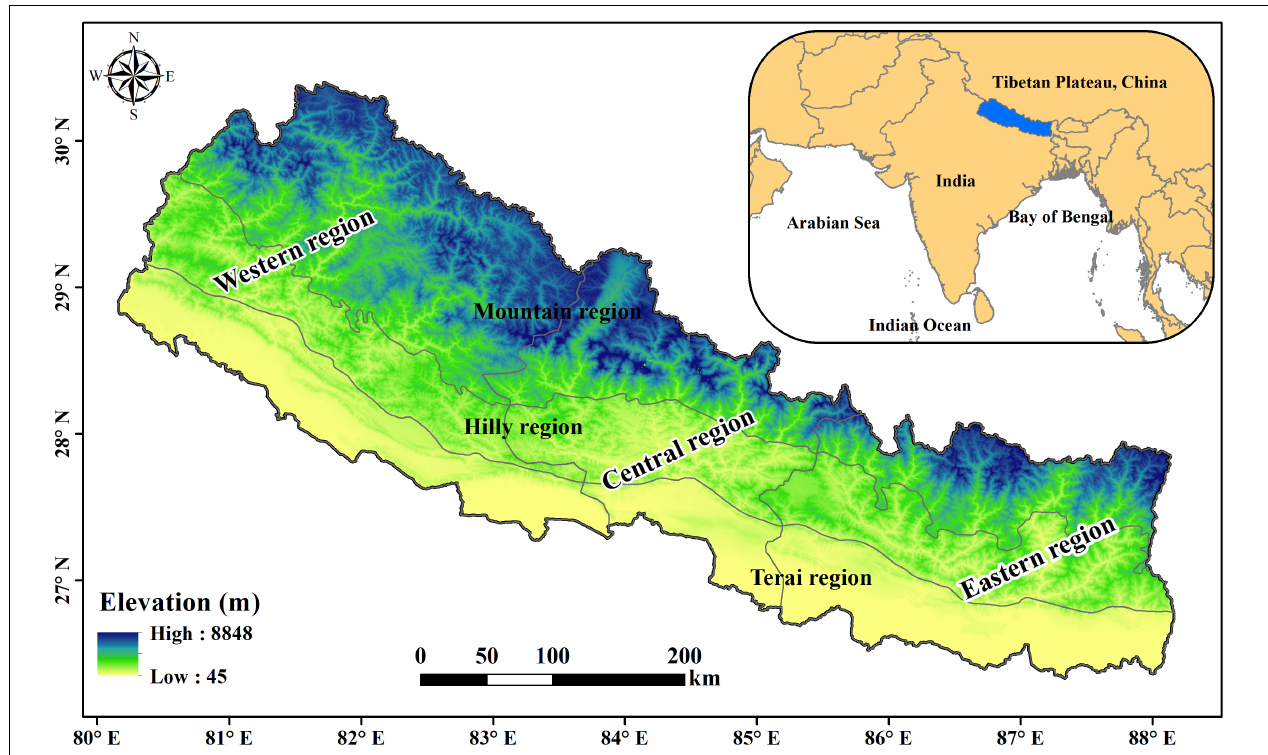
FIGURE 1 | The study area, Nepal with different regions. The inset shows the location of Nepal in relation to the ocean and landmasses.